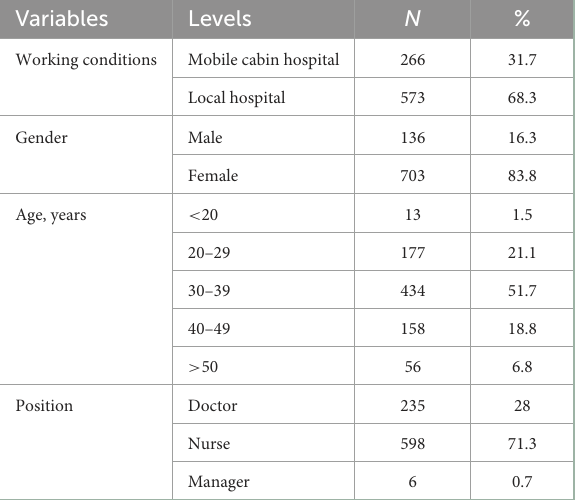
TABLE 1 Demographic characteristics of the